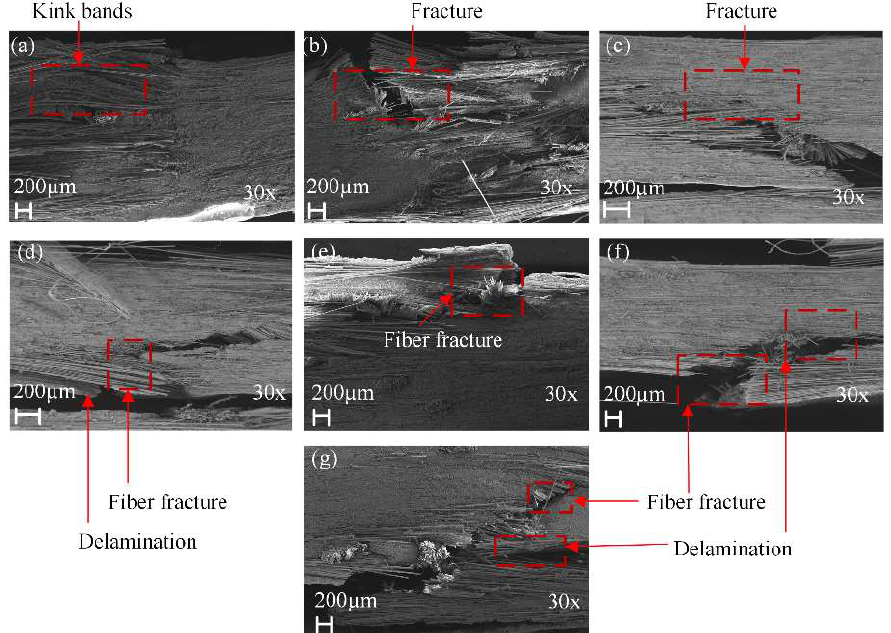
Figure 19. SEM images of seawater conditioned flexural specimens ( a ) GF ( b ) BF ( c ) GB1 ( d ) GB2 ( e ) GB3 ( f ) GB4 ( g ) GB5.